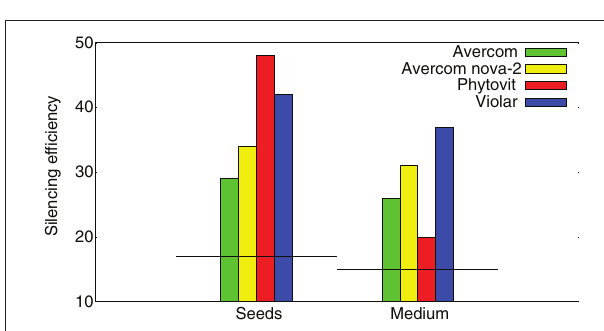
FIGURE 4 | Effects of biostimulants on silencing activity of si/miRNA isolated from nematode-infested plants grown using biostimulants in planta , i.e., a percentage of inhibition of protein synthesis on the template of nematode mRNA in a wheat germ cell-free system, measured per 1µg of protein. Horizontal black lines denote the respective levels of silencing activity achieved by si/miRNA isolated from nematode-infested plants grown without the use of